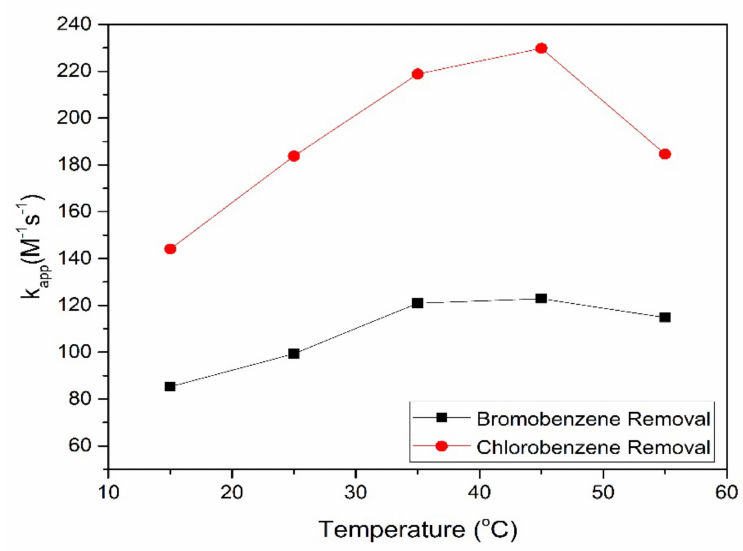
Figure 8. Relationship between T and k app value on HBD